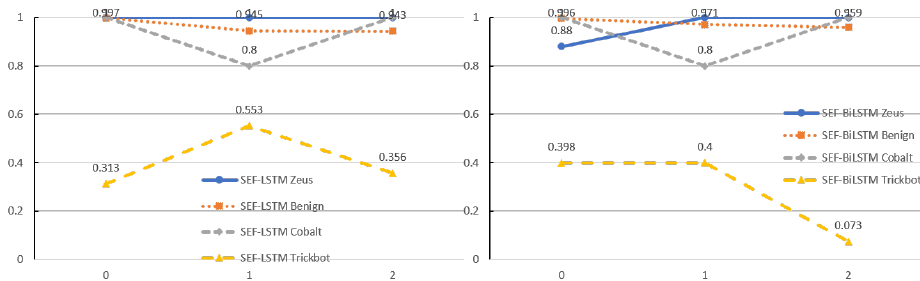
Figure 8. Multiclass target evaluation results using SEF-LSTM and SEF-BiLSTM. The x-axis is the payload from zero (with no binning), one, and two or more, while the y-axis is the F1